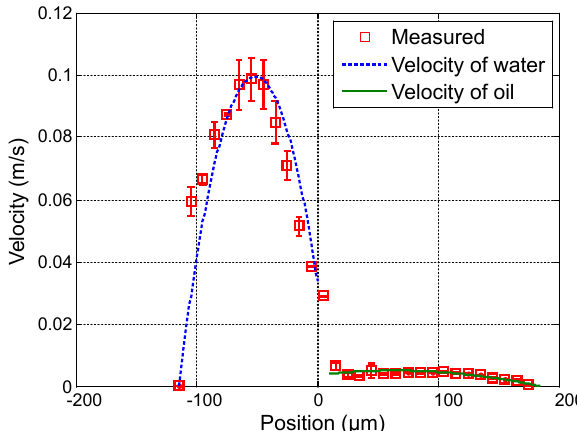
Figure 8. Measured profile with Q water = 40 µL · min − 1 and Q oil = 3 µL · min − 1 . The reference image is the same as Figure 7b.